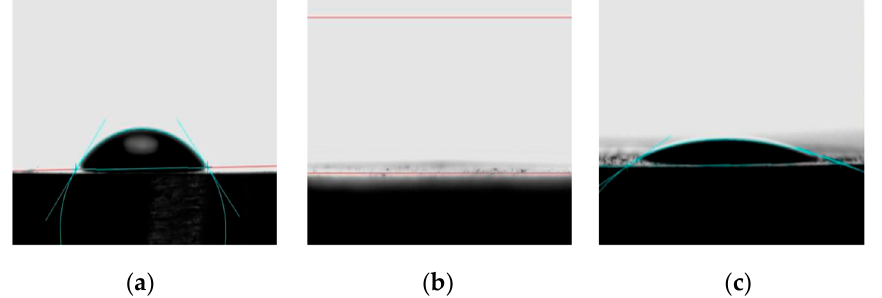
Figure 5. Contact angle measurements (blue lines indicate the angles). Images of a water droplet on the surface of ( a ) pure Ti surface, ( b ) Ti disc after alkaline hydrothermal treatment (TTNT), ( c ) Ti disc after addition of metronidazole (MNZ) and a layer of PVA (TTNT + MNZ +